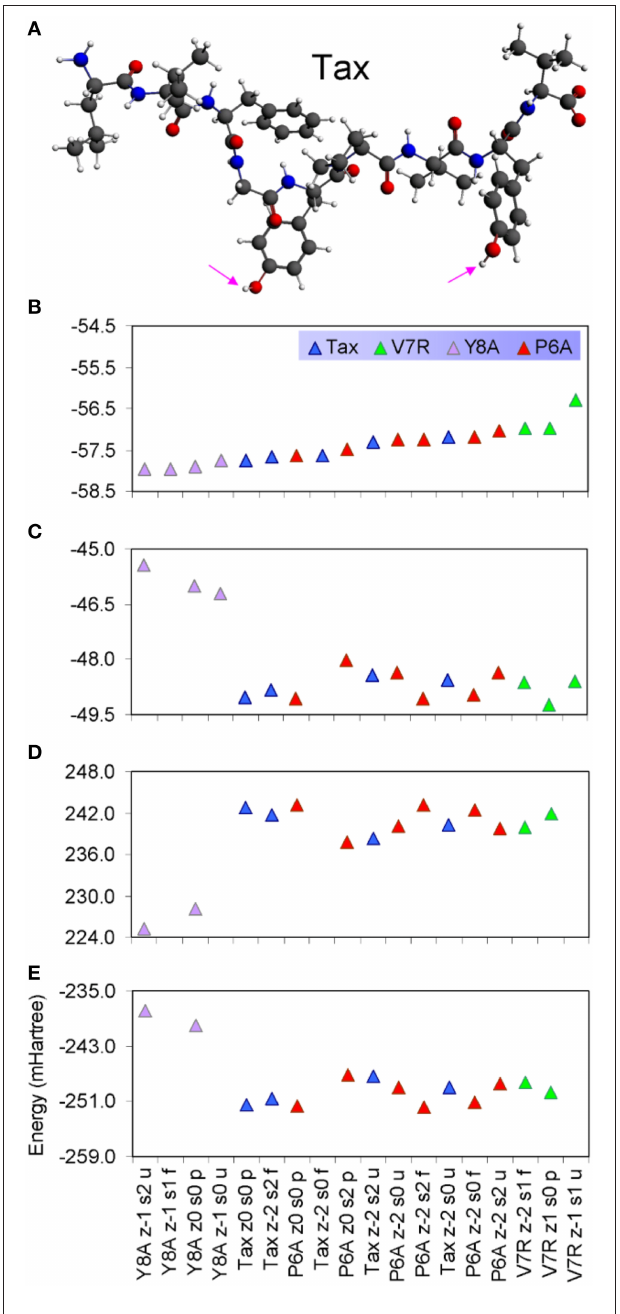
FIGURE 5 | (A) The protonated Tax structure in which H atoms are shown in white color. We deemed that each of the protonated peptides could potentially give rise to two stereochemical variants: one in which the hydroxyl groups attached to phenol side chains would be fully protonated and one in which